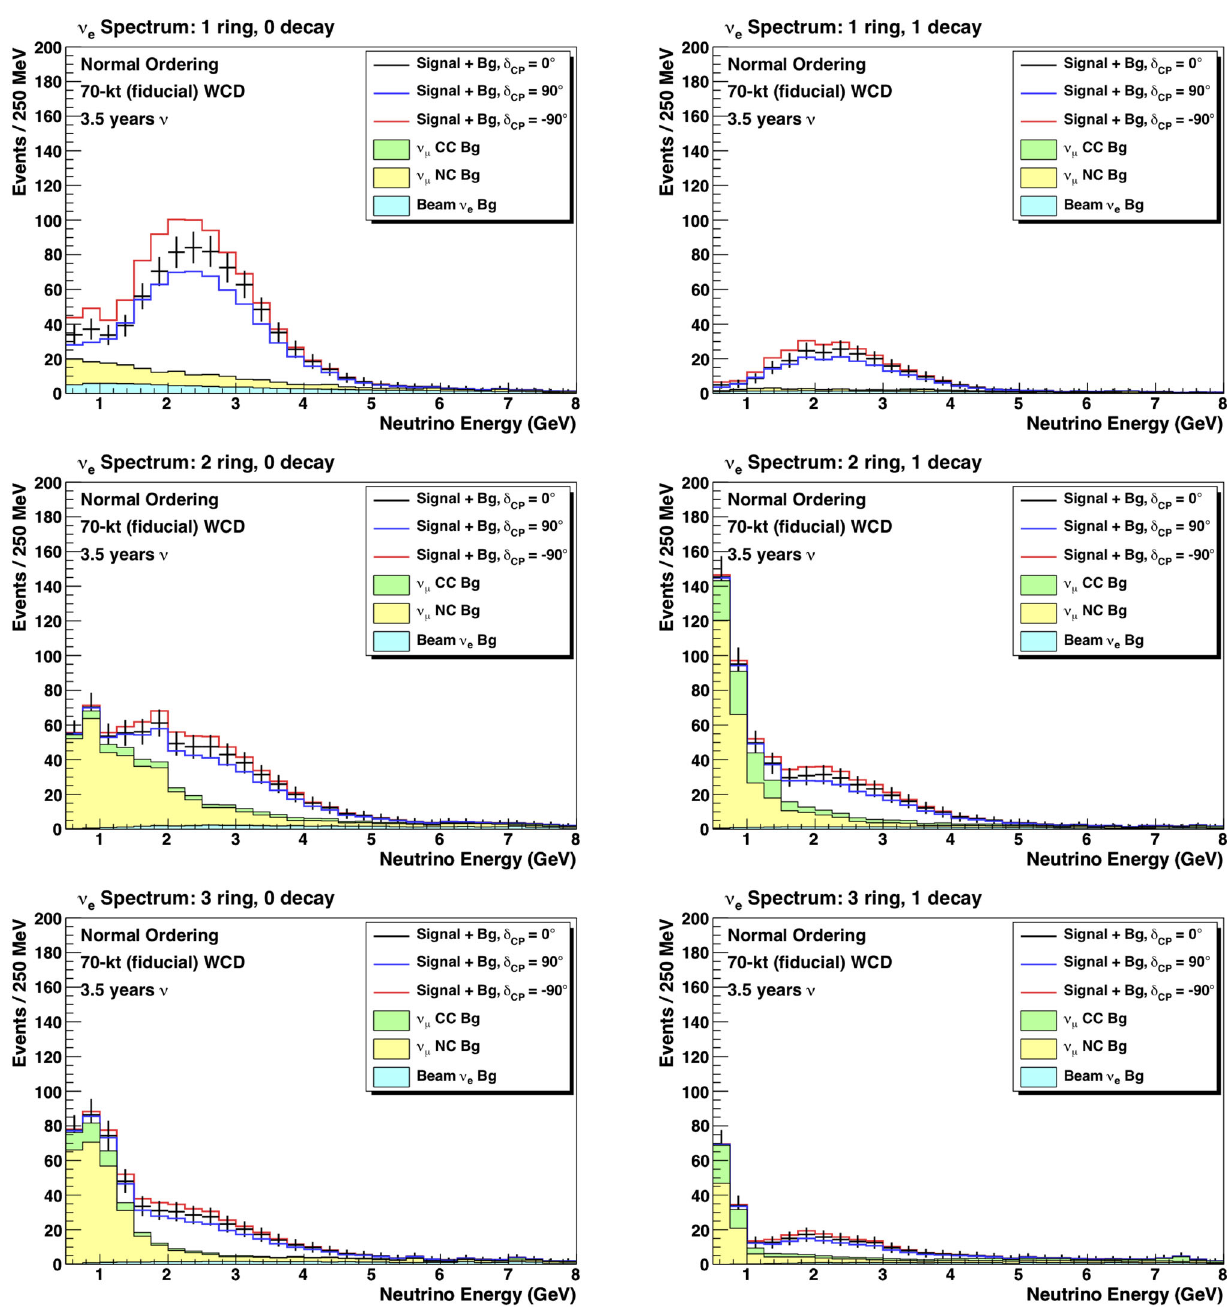
Fig. 5 Expected event rates in neutrino mode as a function of reconstructed neutrino energy for Theia -100 after 3.5 years in the LBNF beam for the six selected neutrino-mode samples: one ring (top), two ring (middle), three ring (bottom) with zero Michel electrons (left) or one Michel electron